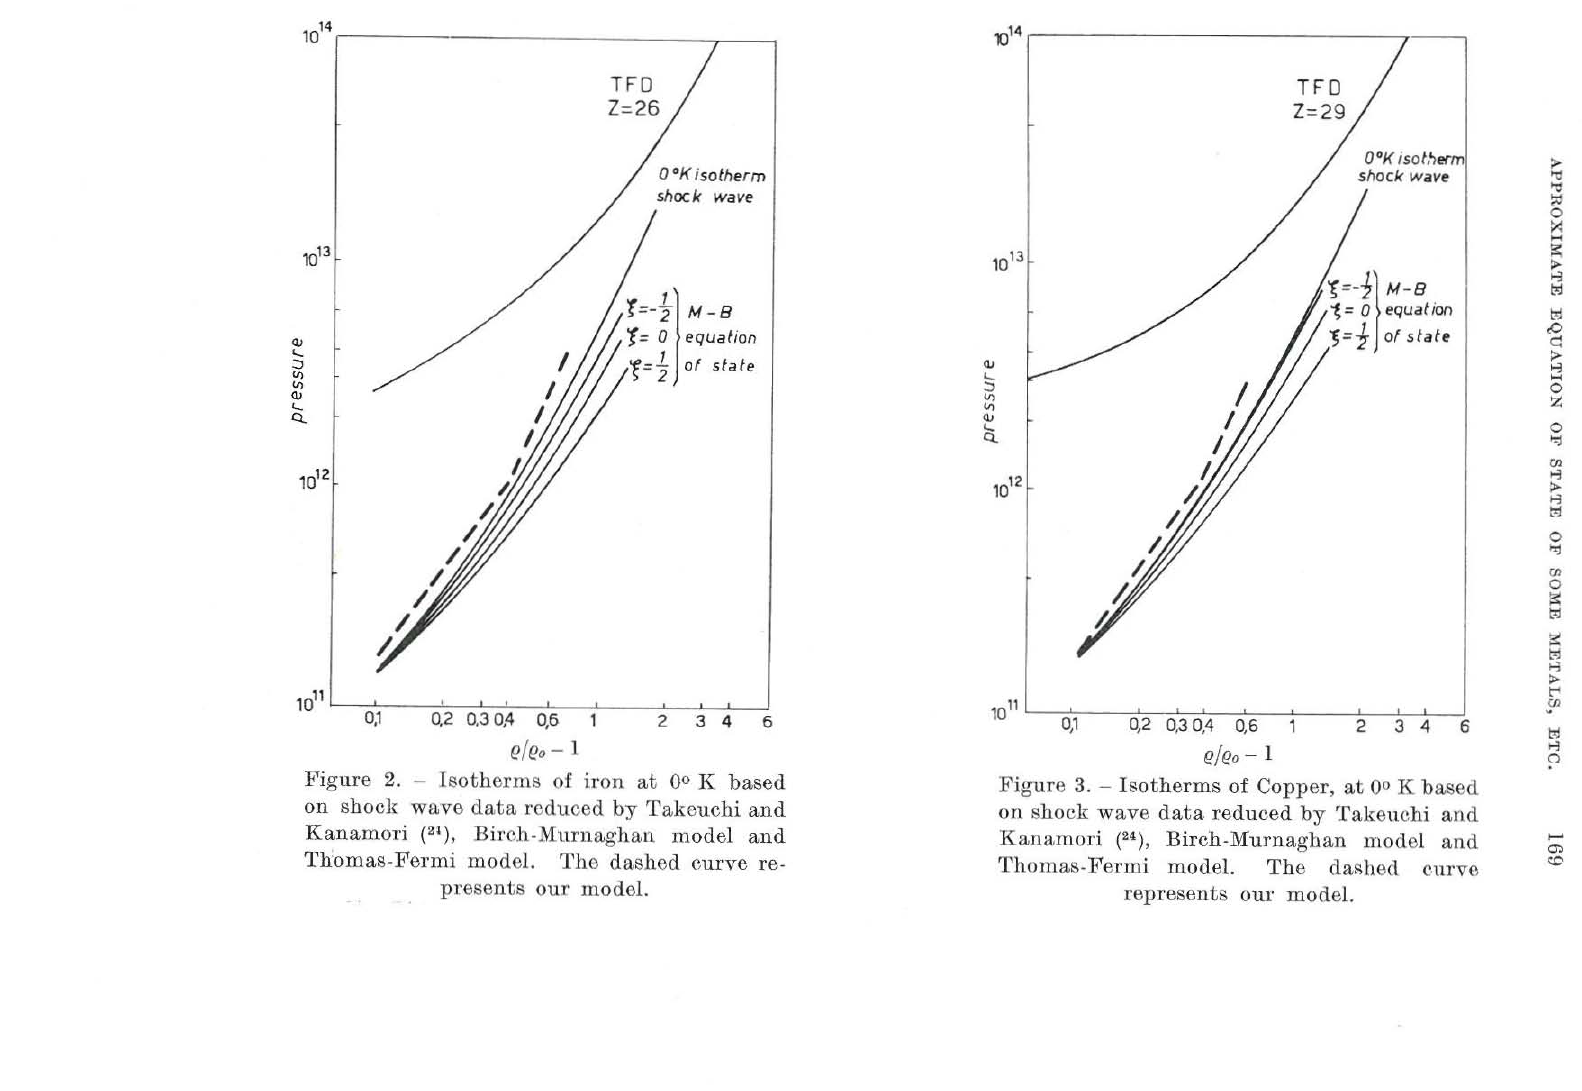
Figure 2. - Isotherms or il'on at 0° K based on shock wave data l'cduced by Takouchi arrd Kanamori (21), Bil'ch.Murnaghan model arrd Thomas·Fenni mode!. The dashed curve re· presents OUI fiodei.